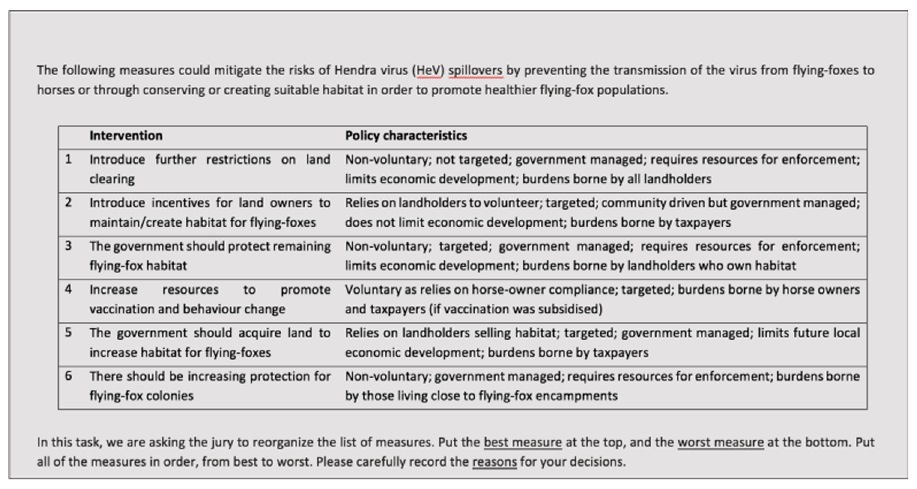
Fig 2. The prioritisation task for the community